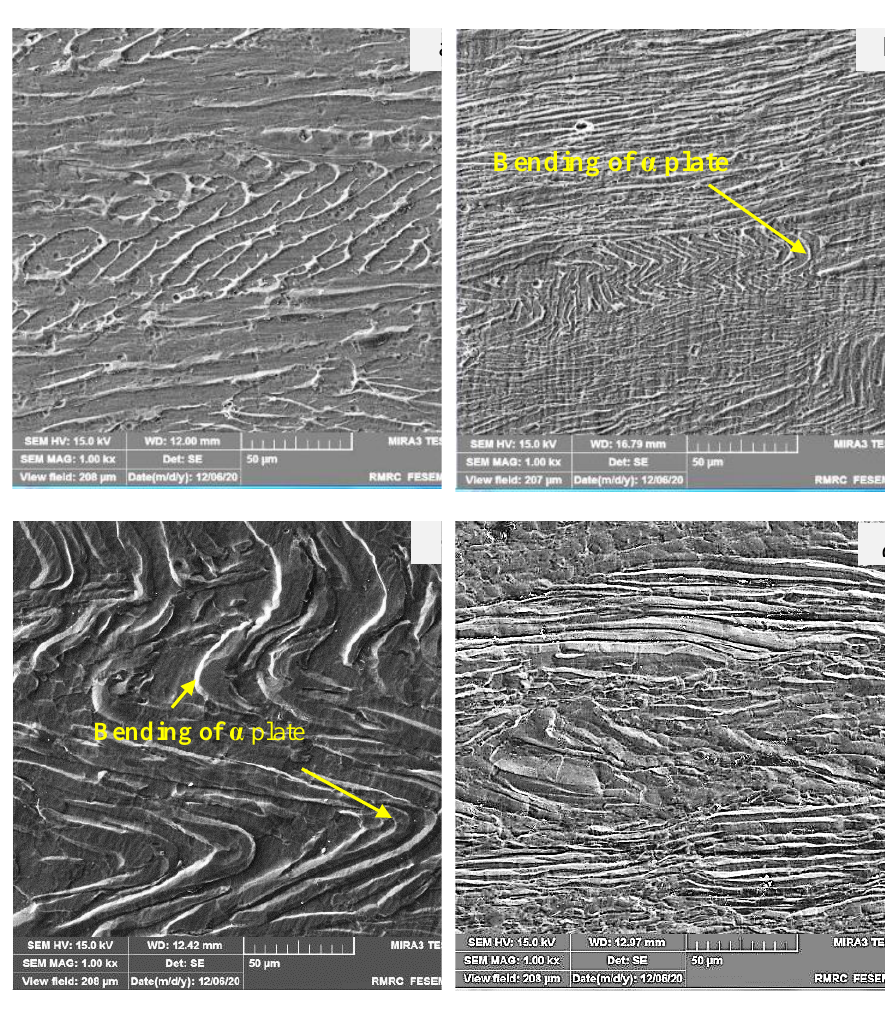
Fig. 9. Microstructure evolution of ATI425 alloy at various conditions in alpha/beta region: (a) 700°C and strain rate 0.001s -1 , (b) 700°C strain rate 0.01s -1 and (c) 800°C strain rate 0.1s -1 (c) 800°C strain rate 1s -1